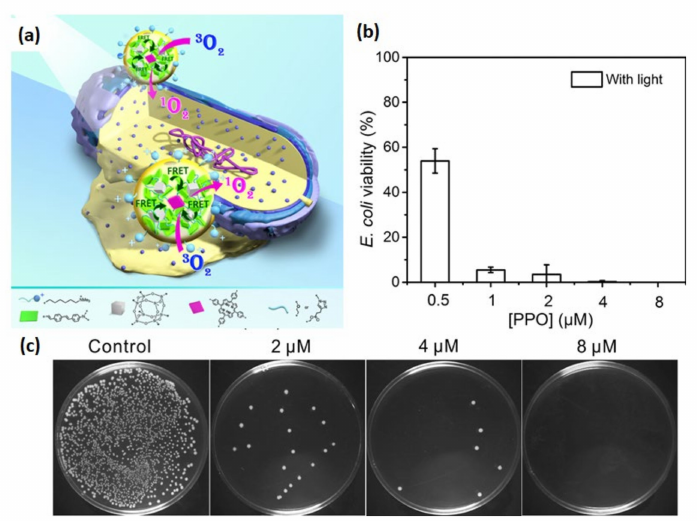
Figure 6. POSSP derivatives which were synthesized in [27]. POSSPs 1–3 contain hydrophobic groups. POSSPs 4 and 5 are functionalized with hydrophilic moieties.